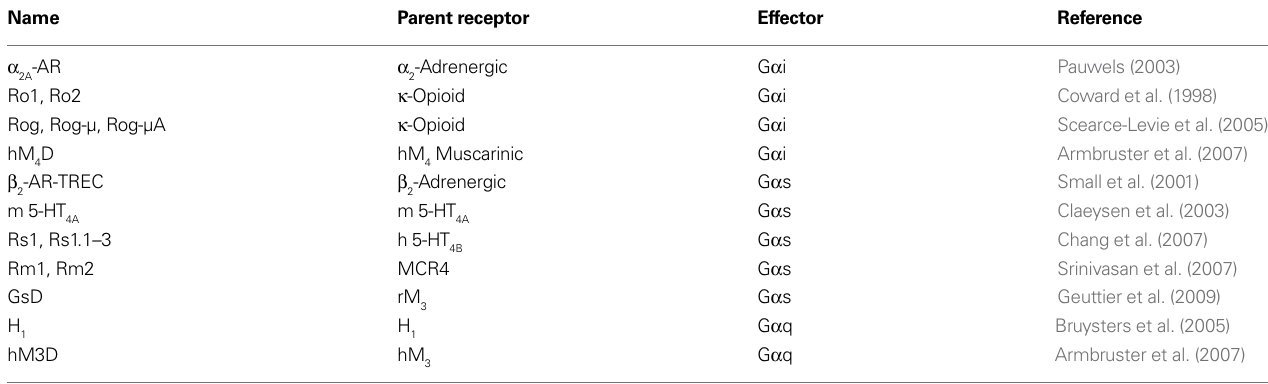
Table 1 | The major RASSL and DREADD receptors grouped according to the primary G-protein activated. The parent receptor of each is